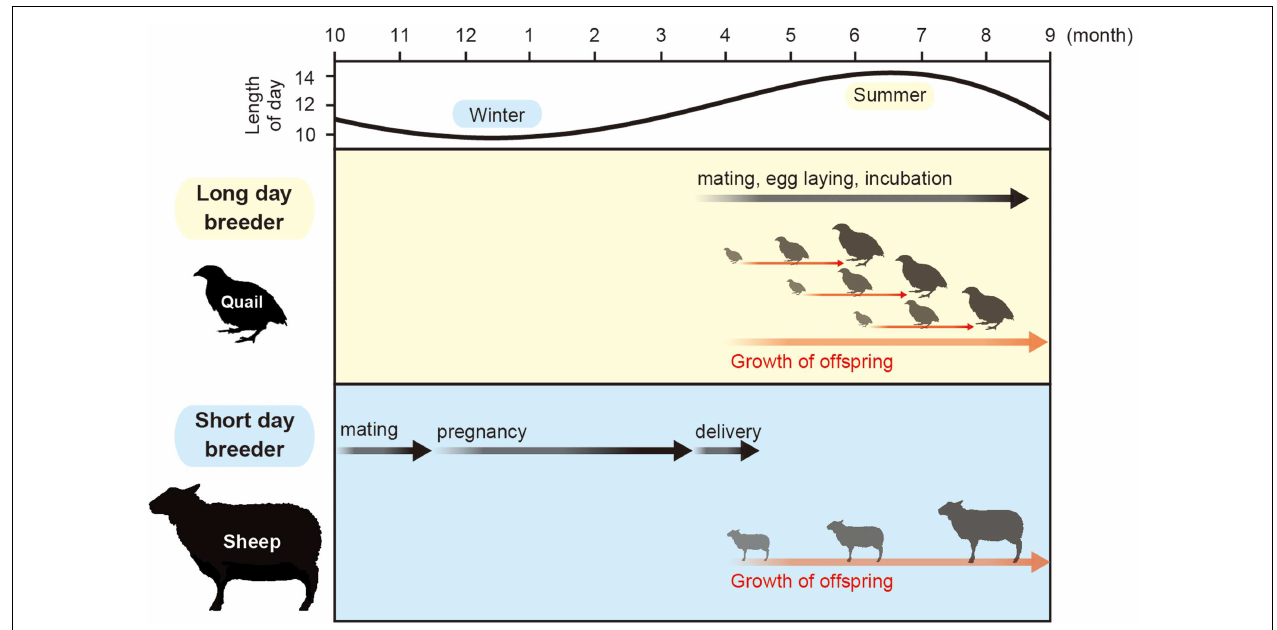
FIGURE 1 | Calendar of seasonal breeding animals . Most animals mate in a specific time of a year. Small animals with short gestation or incubation period mate in spring and summer, while large animals that have a 6-month gestation period mate in fall to give birth in